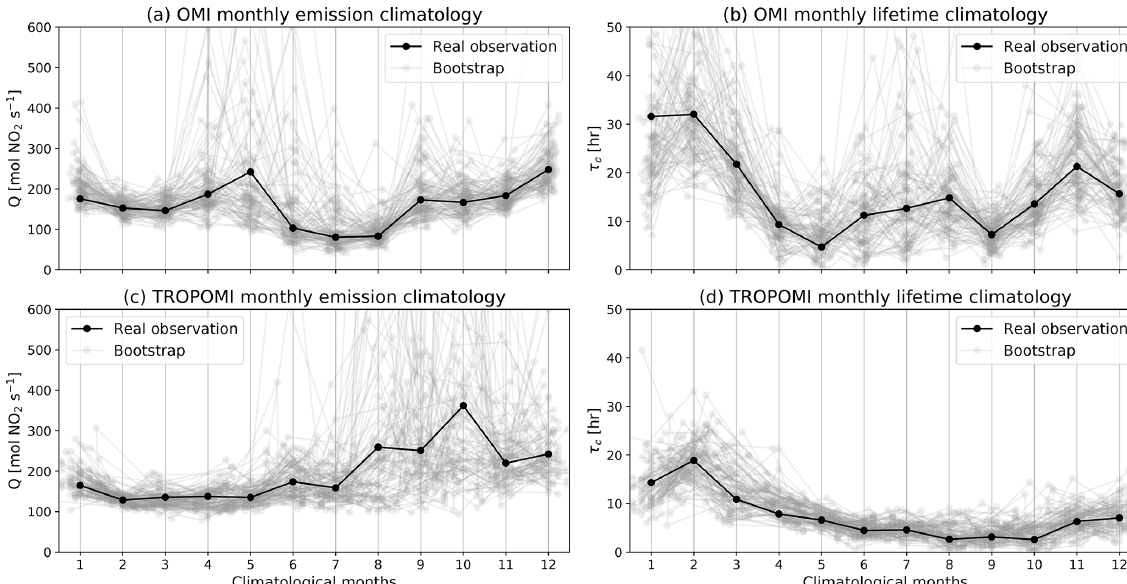
Figure 4. Fitting of the column–wind speed relationships for each climatological month for OMI (a, b) and TROPOMI (c, d) . The black symbols are fitted from real observed data, and the gray symbols are bootstrapping realizations.